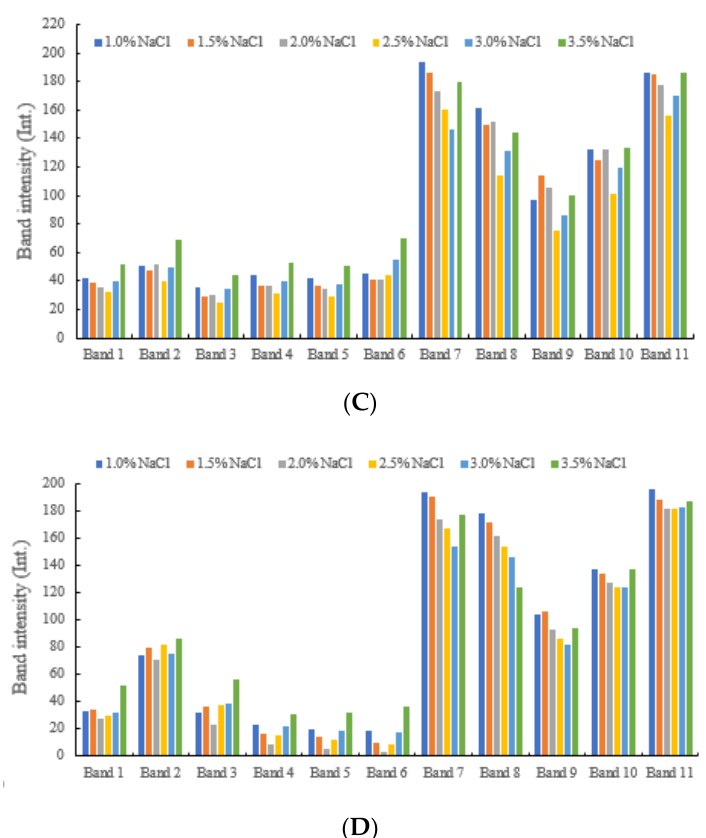
Figure 4. Effects of different NaCl concentrations on protein pattern of SG ( A ) and MG ( B ). ( C ): the intensity of bands in ( A ); ( D ): the intensity of bands in ( B ).